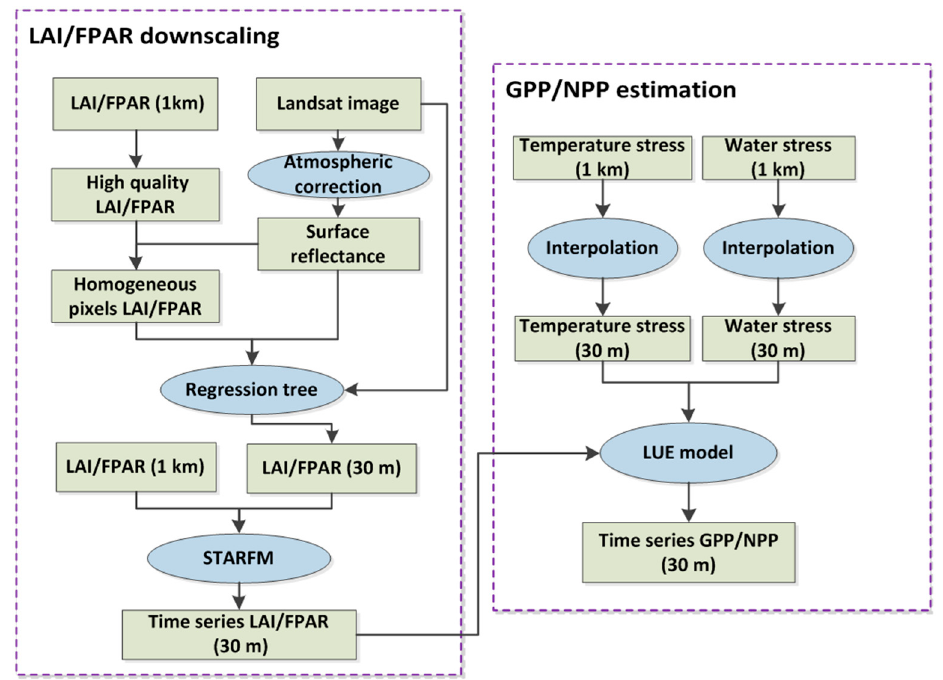
Figure 3. Flowchart of gross primary production (GPP) and net primary production (NPP) estimates from downscaling methods. High resolution (30 m) fraction photosynthetically active radiation (FPAR) and leaf area index (LAI) were firstly obtained by using a downscaling method, then time series high resolution (30 m) GPP and NPP were estimated by using a Light Use Efficiency (LUE) model.